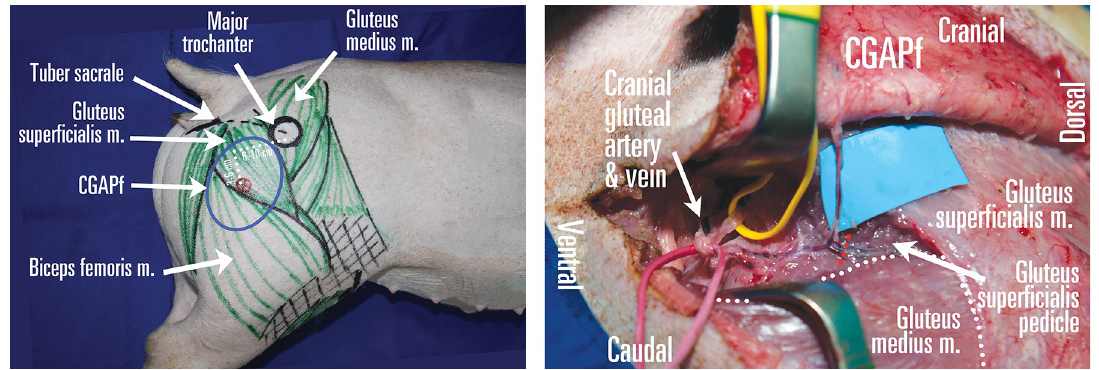
Fig 3. Cranial gluteal artery perforator flap (CGAPf) planning in pigs. (A) Cranial gluteal artery (CGA) perforator pierces first the gluteus medius m. followed by gluteus superficialis m. on its way to the skin and is consistently located 6–10 cm caudal and 3–6 cm ventral from the major trochanter. (B) The CGA terminal branches are the gluteus superficialis m. pedicle and the CGA perforator, which has a long intramuscular course. The gluteus superficialis m. pedicle has to be transected (red dotted line) in order to reach the CGA, about 6 cm deep. Republished from personal archive under a CC BY license, with permission from Dr. Nistor Alexandru, original copyright